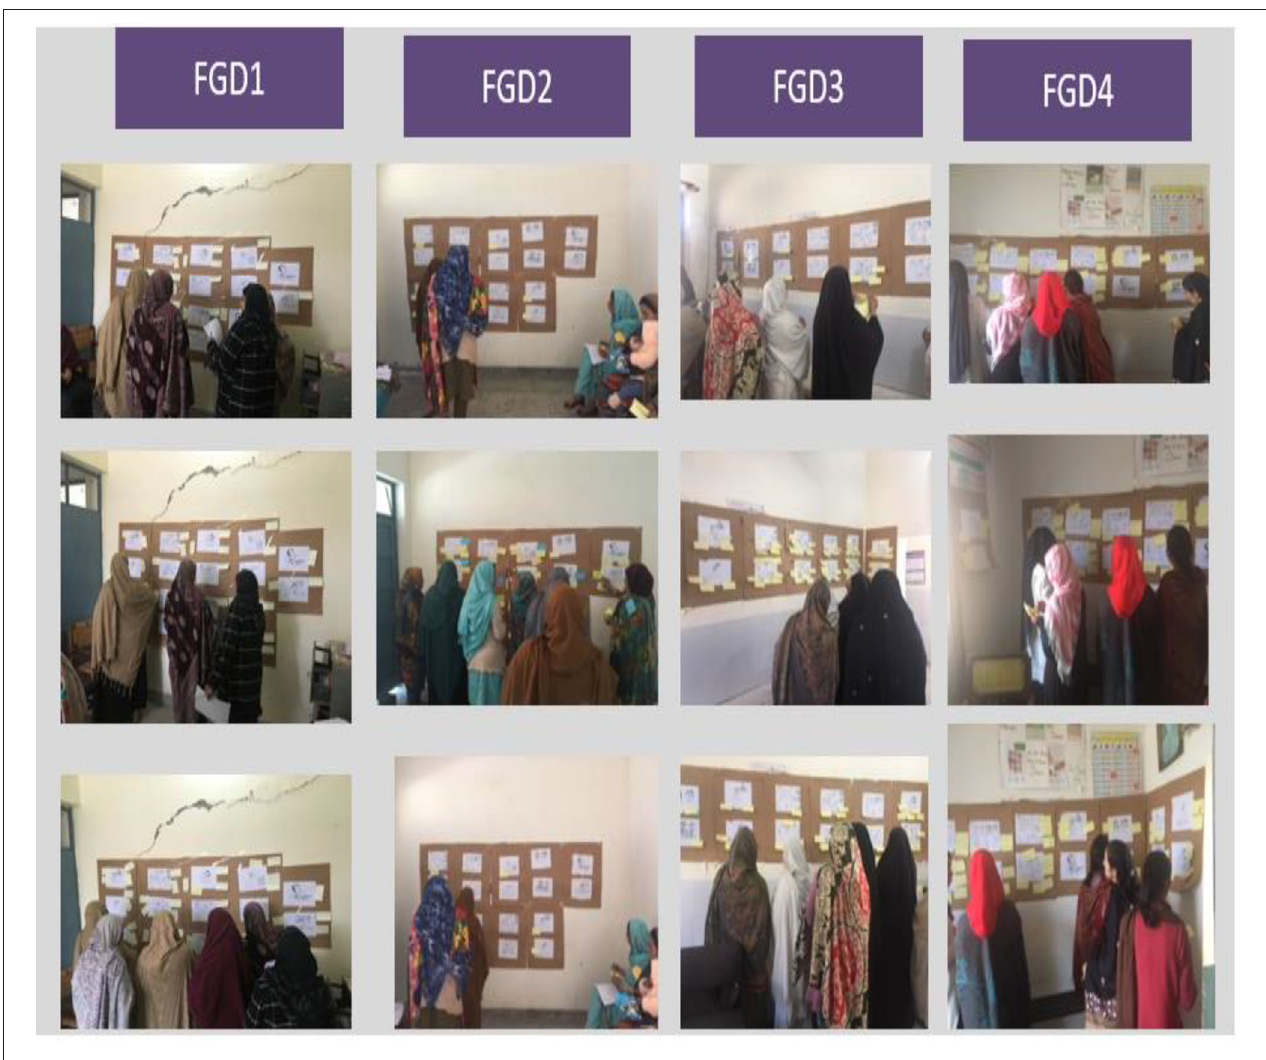
FIGURE 1 | Card to pictorial illustration matching